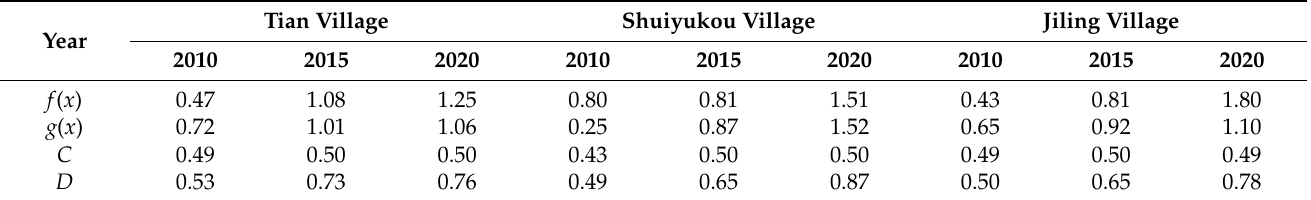
Table 8. Coupling coordination between production land and living land in rural settlements.